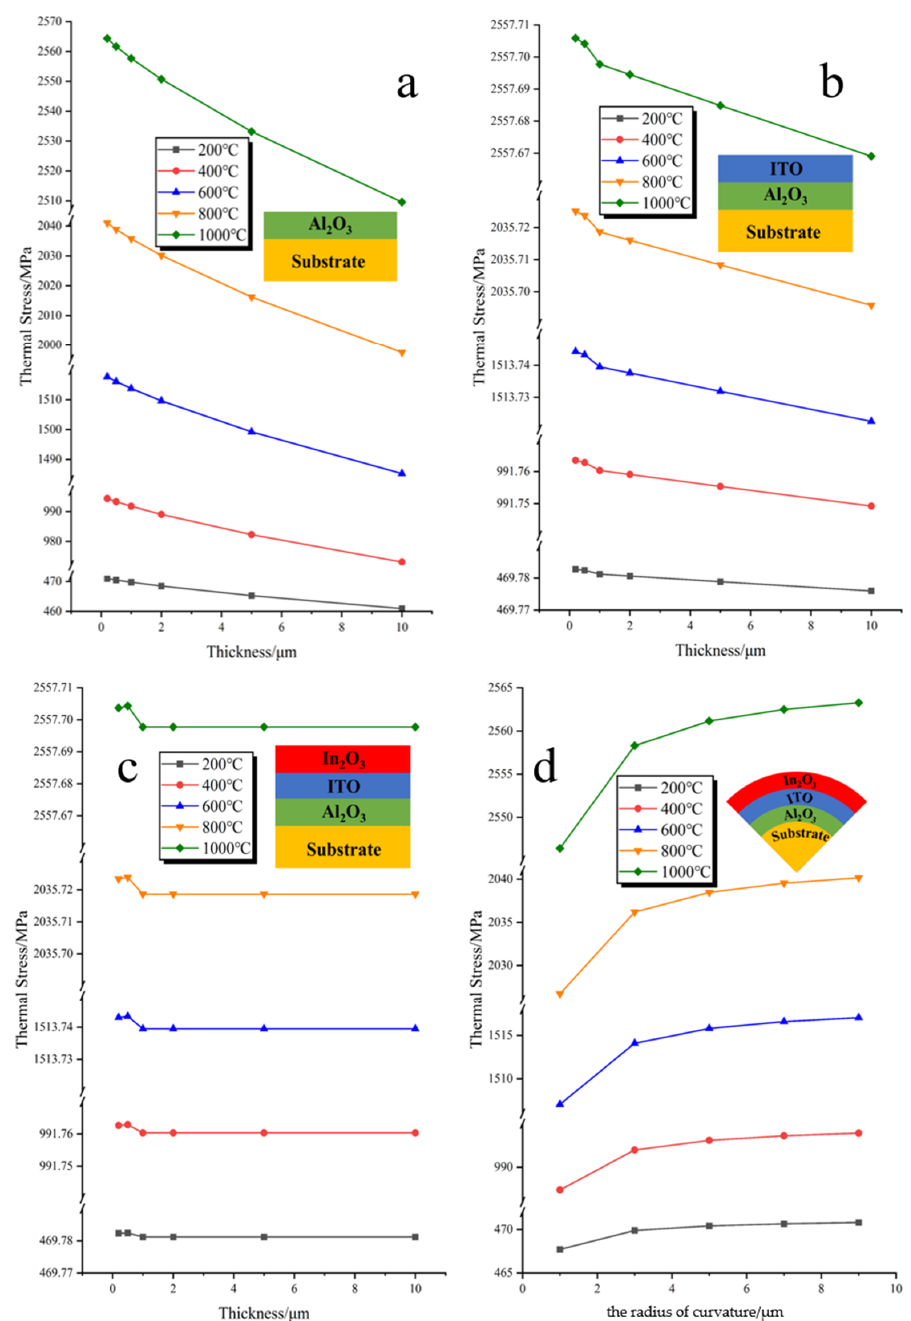
Figure 7. Thermal stress as a function of the Al 2 O 3 film thickness for different systems: ( a ) Al 2 O 3 film and substrate; ( b ) ITO film, Al 2 O 3 film, and substrate; ( c ) TFTC, Al 2 O 3 film, and substrate with R = 1 mm; ( d ) thermal stress as a function of R for the system composed of the TFTC, Al 2 O 3 film, and substrate.